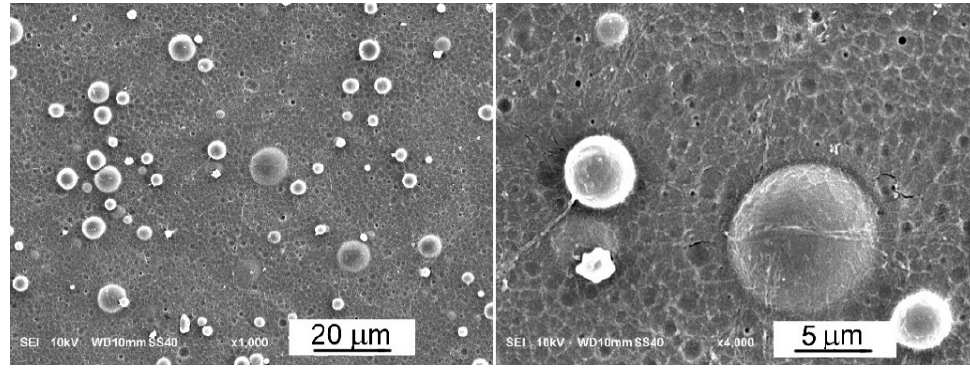
Figure 3. SEM micrographs of PLA/PMMA blend film etched for 1 h.